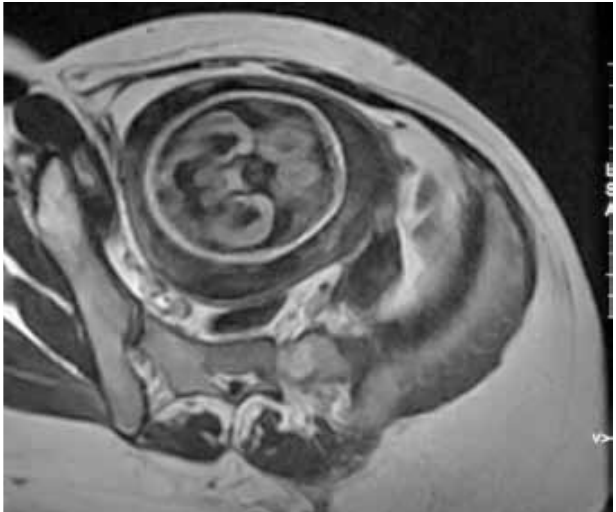
Fig. 3. Case 3: Axial fetal MRI: ‘Molar tooth’ sign consistent with Joubert syndrome and related disorders.